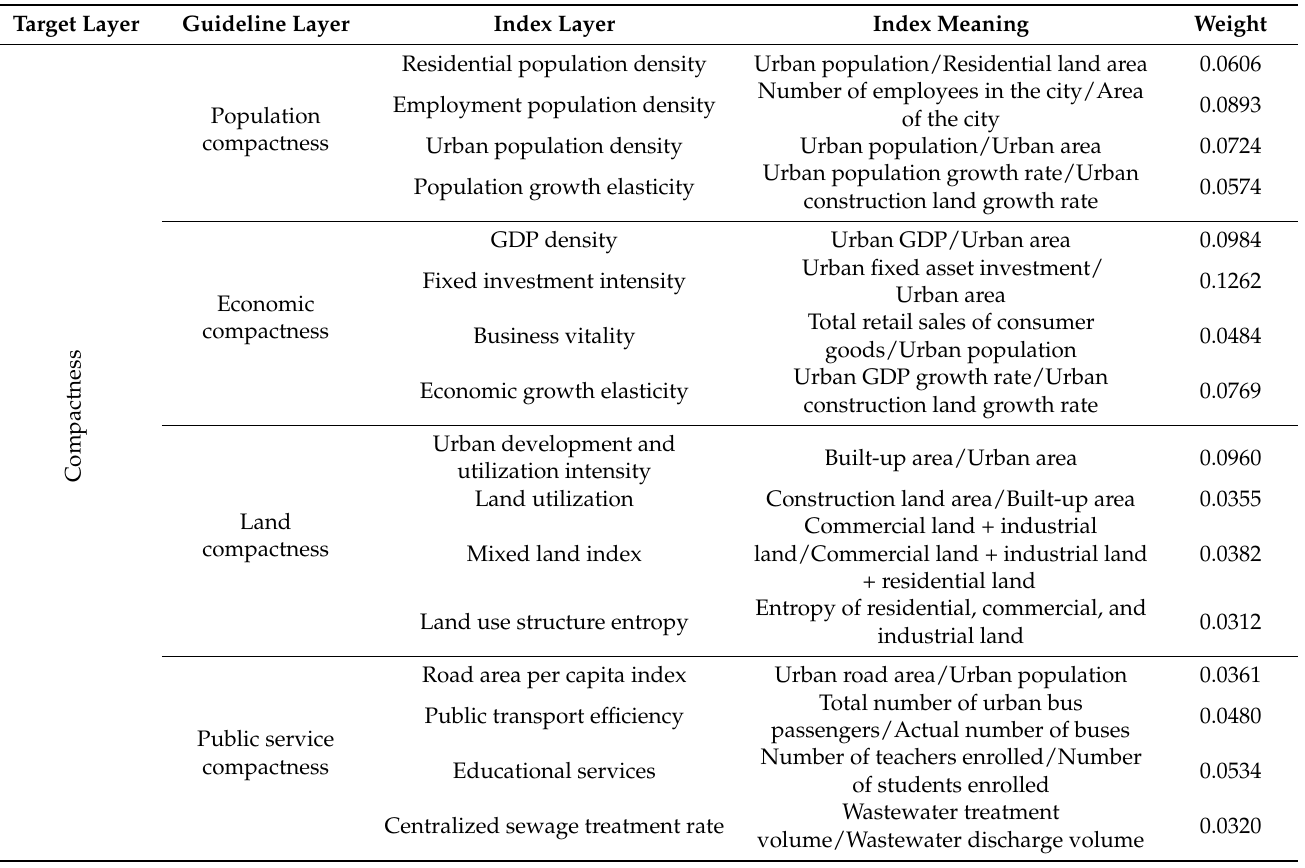
Table 2. Urban compactness evaluation index